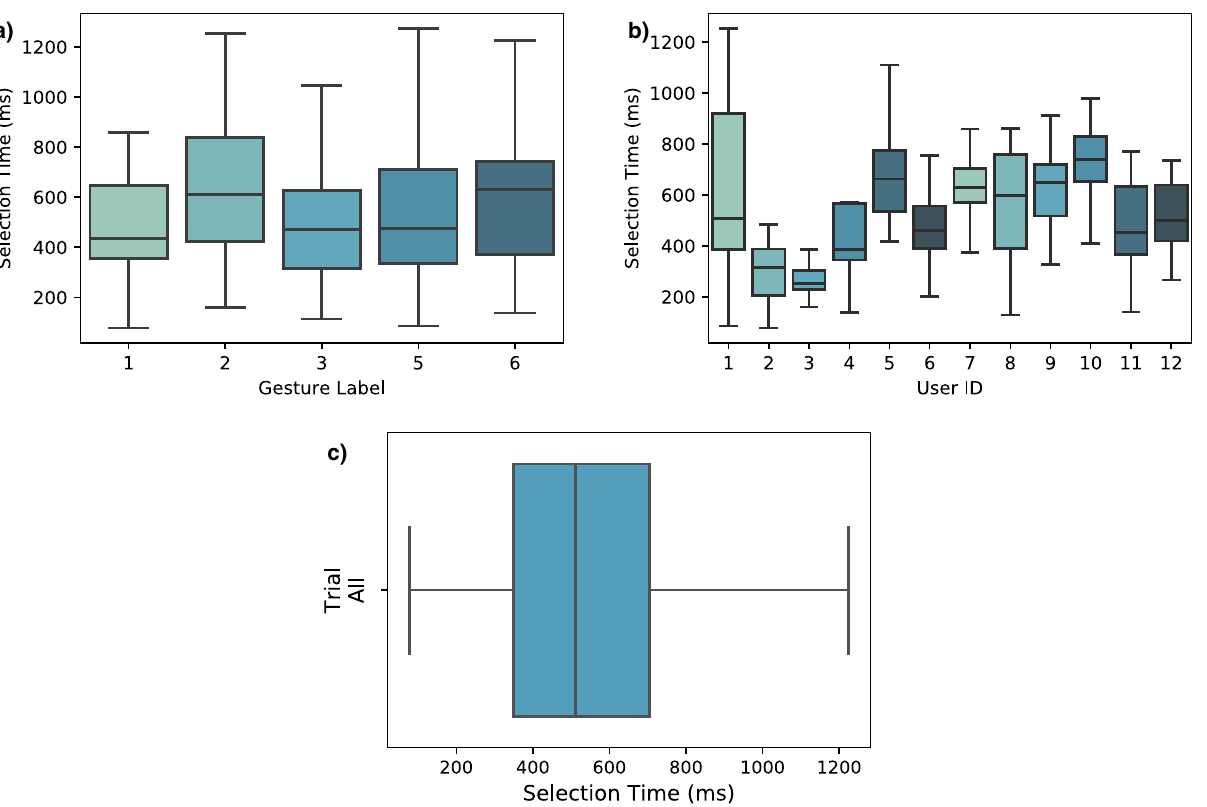
Figure 7. Motion selection time evaluation. ( a ) Motion selection time of the real-time trials per gesture label and ( b ) per user. ( c ) Results of all trials across all participants shown on a box plot. The median ST is 512.05 ms with a minimum reaching 78 ms. Selection times are shown for all gesture labels except label 4 since it is the neutral hand state used in all trials as a starting position.